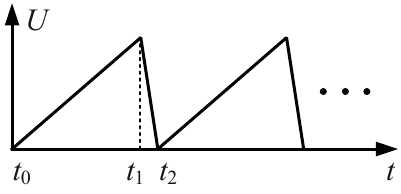
Figure 2. The sawtooth driving voltage for the PES.